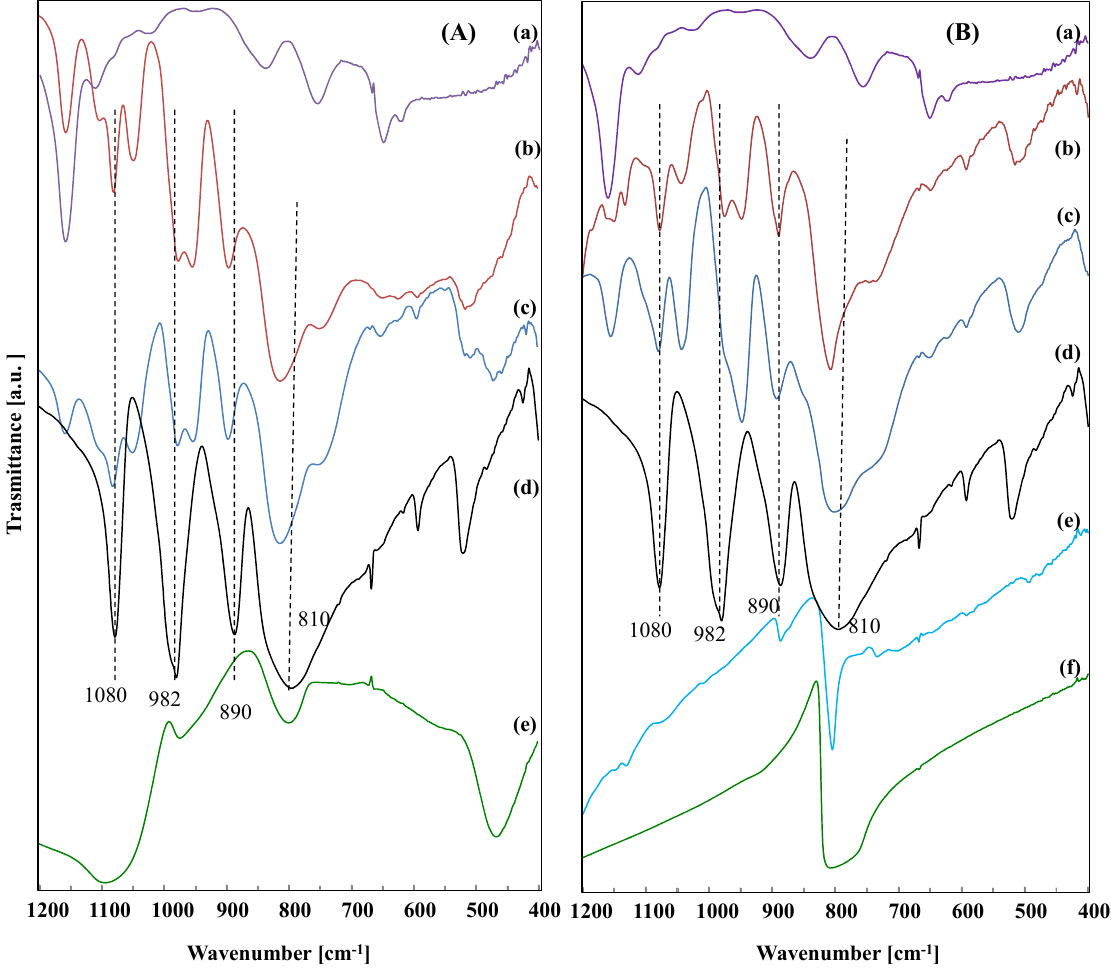
Figure 4. FTIR spectra of ( A ): ( a ) imi ; ( b ) TiO 2 − imi − PW 12 ; ( c ) SiO 2 − imi − PW 12 ; ( d ) PW 12 and ( e ) SiO 2 ; and ( B ): ( a ) imi ; ( b ) C 3 N 4 − imi − PW 12 ; ( c ) BN − imi − PW 12 ; ( d ) PW 12 ; ( e ) C 3 N 4 and ( f ) BN.